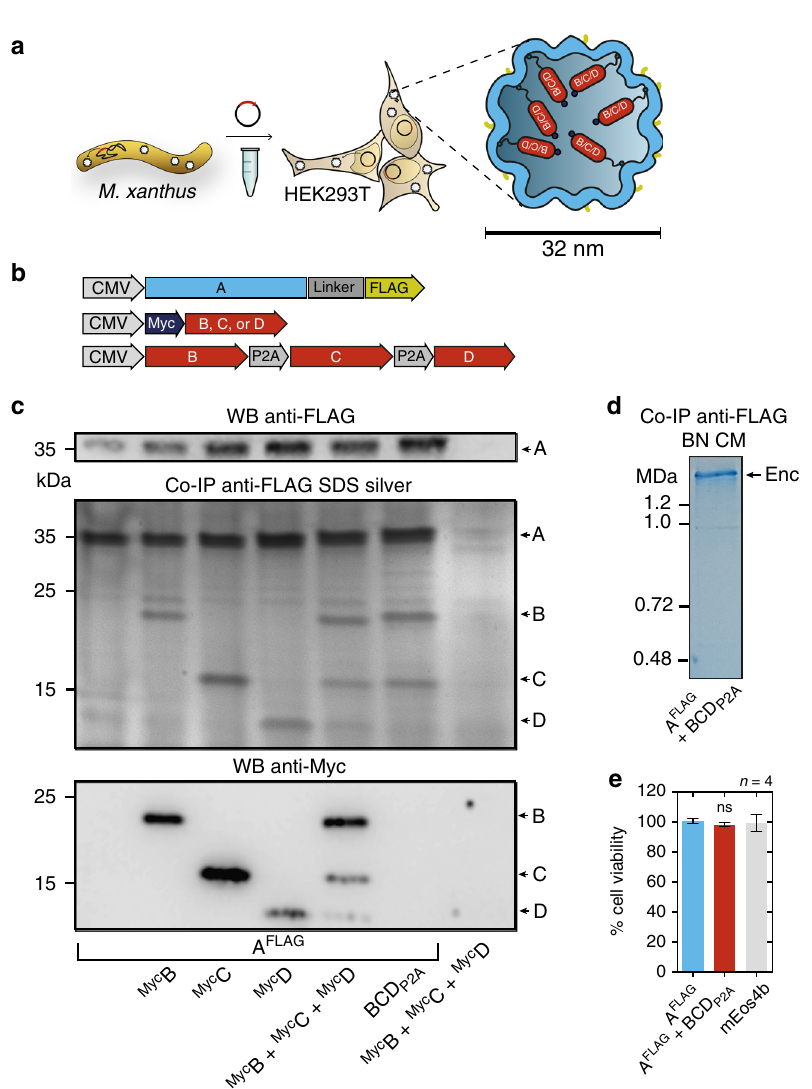
Fig. 1 Assembly of encapsulins and targeting of cargo in HEK293T cells. a Schematic of the heterologous expression of surface-modi fi ed encapsulin variants loaded with endogenous cargo proteins. b Genetic constructs encoding the shell protein A (light blue) with a FLAG-tag as C-terminal surface modi fi cation as well as individual Myc-tagged cargo proteins (red) B, C, and D that can also be combined in a multi-gene expression construct (BCD P2A ). c Co-immunoprecipitation of A FLAG and silver-stained SDS-PAGE from cells co-expressing just B, C, or D, or a combination of these three proteins expressed either via a mixture of individual DNA constructs ( Myc B + Myc C + Myc D), or by a multi-gene expression construct (BCD P2A ). The top panel shows a western blot (WB) against the exterior FLAG-tag in A FLAG . The bottom panel shows the corresponding WB against the Myc epitope. d Coomassie-stained Blue Native PAGE (BN CM) of puri fi ed material from HEK293T expressing A FLAG and BCD P2A yielding a band above 1.2 MDa. e Cell viability after 48 h of overexpression of encapsulins (A FLAG ) with or without cargo (BCD P2A ) assessed by an LDH release assay. A construct expressing the fl uorescent protein mEos4b served as a control. The bars represent the mean ± SEM ( p = 0.1965, Kruskal – Wallis, n = 4; no signi fi cant (ns) differences at α = 0.05 were found in Dunn ’ s multiple comparisons test between mEos4b and A FLAG expressed without or with BCD P2A